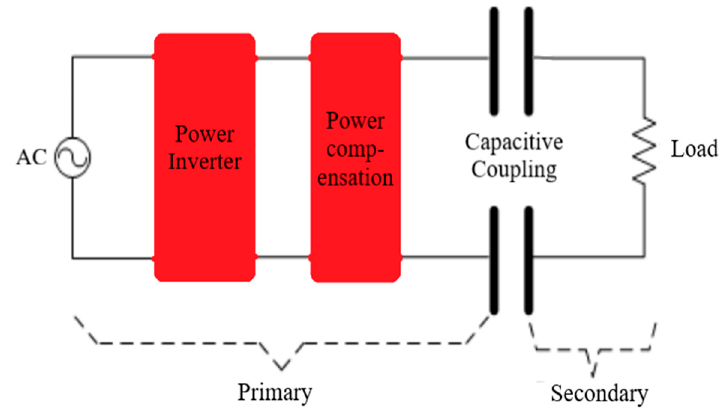
Figure 13. Capacitive wireless power transmission.